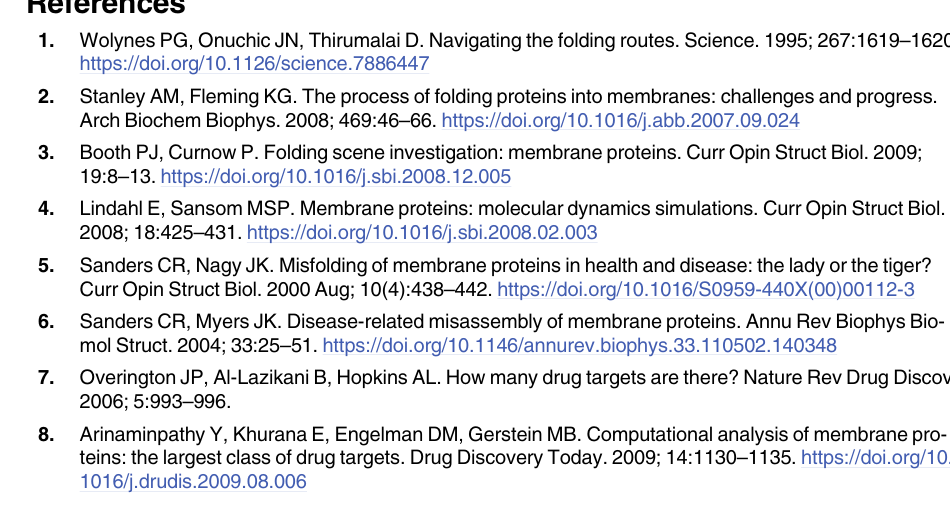
S1 Fig. Plot of the dependence of the apparent barrier height for dimerization as a function of the adjustable parameter λ defining the reaction